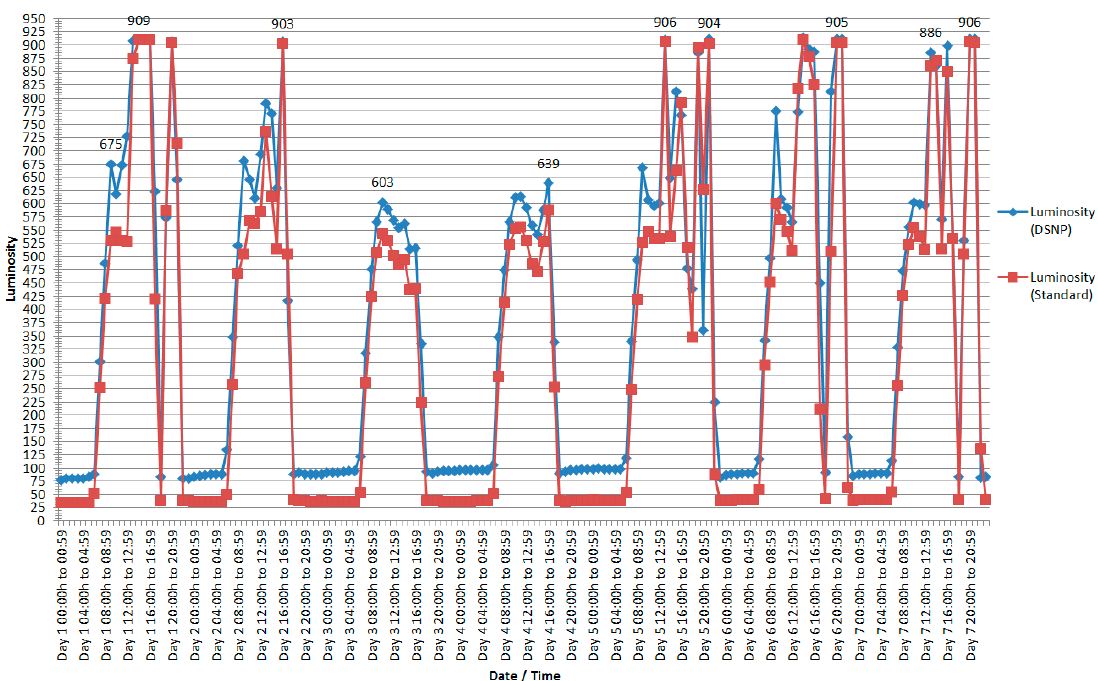
Figure 9. Average luminosity recorded by the standard shape sensors and average luminosity of the sensors recorded using DSNP.